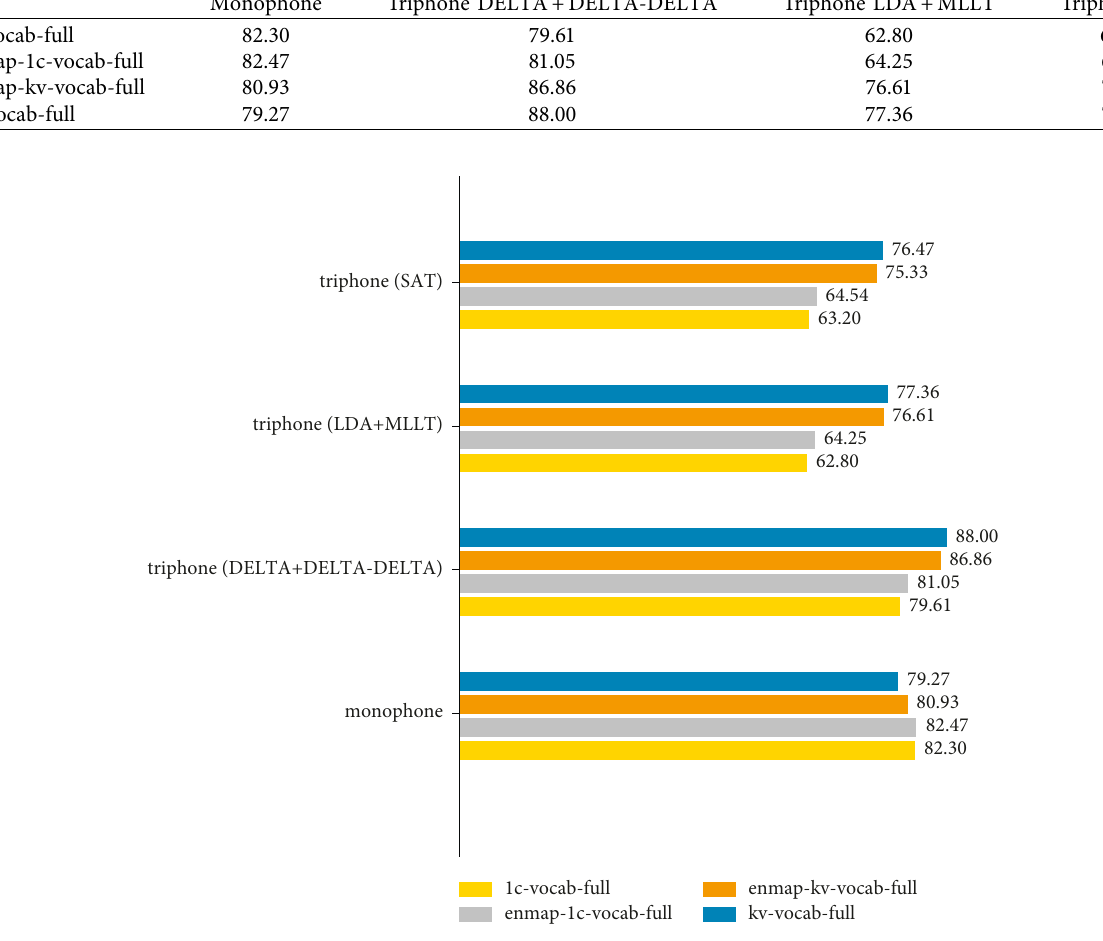
Table 8: The performance of the acoustic models using 10,000 validated utterances. Lexicon type